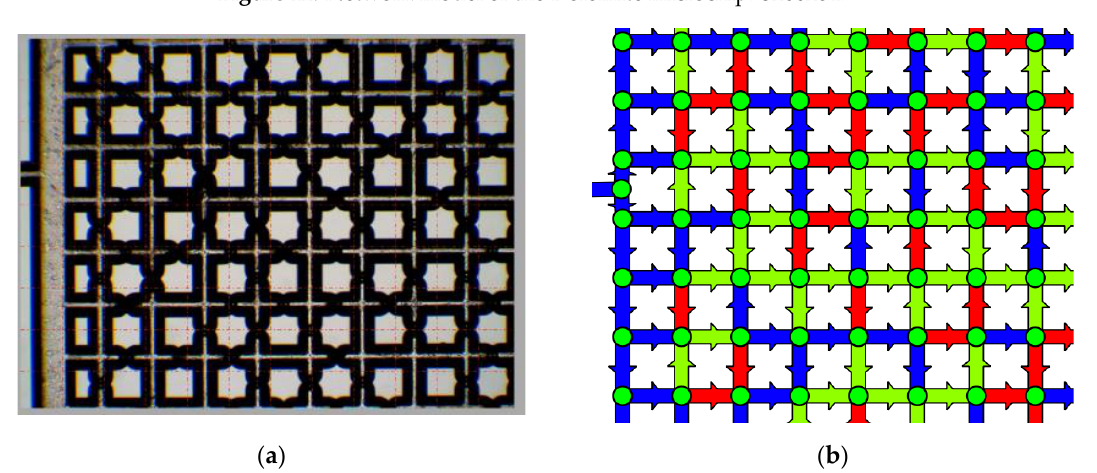
Figure 13. Microchip fragment: ( a ) photo, ( b ) network problem: blue indicates straight channels, green and red — pinched channels, Ø 85 and Ø 63 µm, respectively.